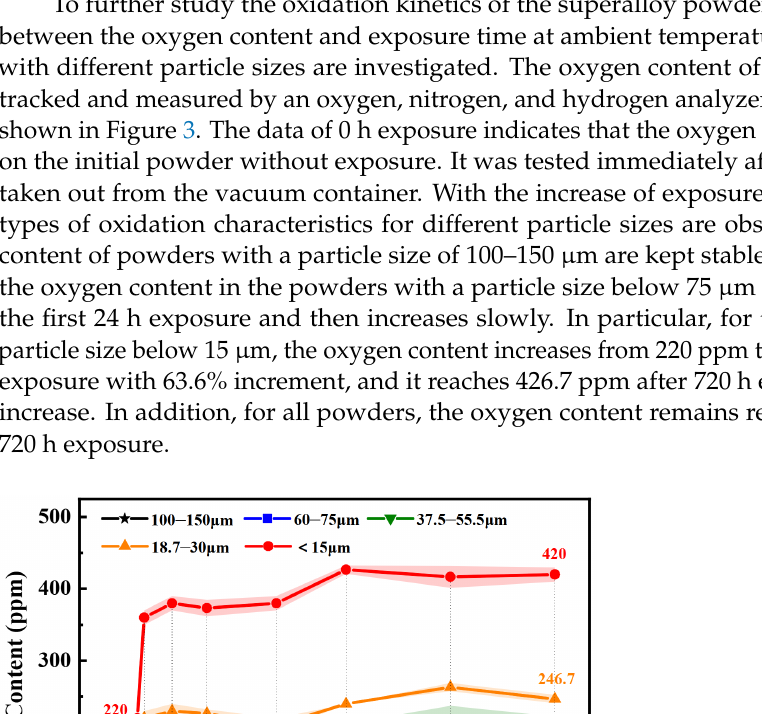
Figure 4. Surface morphology of superalloy powder for different exposure time in air: ( a ) 0 h; ( b ) 720 h; ( c ) 1440 h. 3.4. Characterization of the State of Oxygen Although SEM and EDS analysis failed to detect the oxides and oxygen on the pow- der surface, TG-MS analysis, thermodynamic calculation, and kinetic experiments all showed that the oxygen or oxides must exist at ambient temperature. In order to accu- rately analyze the oxide states of different alloy elements on the superficial layer of the powder, XPS was used for further characterization. The XPS spectra of the initial powder and the powder exposed for 720 h are shown in Figure 5. The results show that oxides already exist on the surface of both initial powder and exposed powder. The valence states that all elements (Al, Co, Cr, Mo, Ni, W, and Nb) on the powders with different particle sizes and exposure time have no significant difference. It indicates that these alloying el- ements can form similar oxides before and after exposure. However, there are two special cases—one is oxygen and the other is titanium.